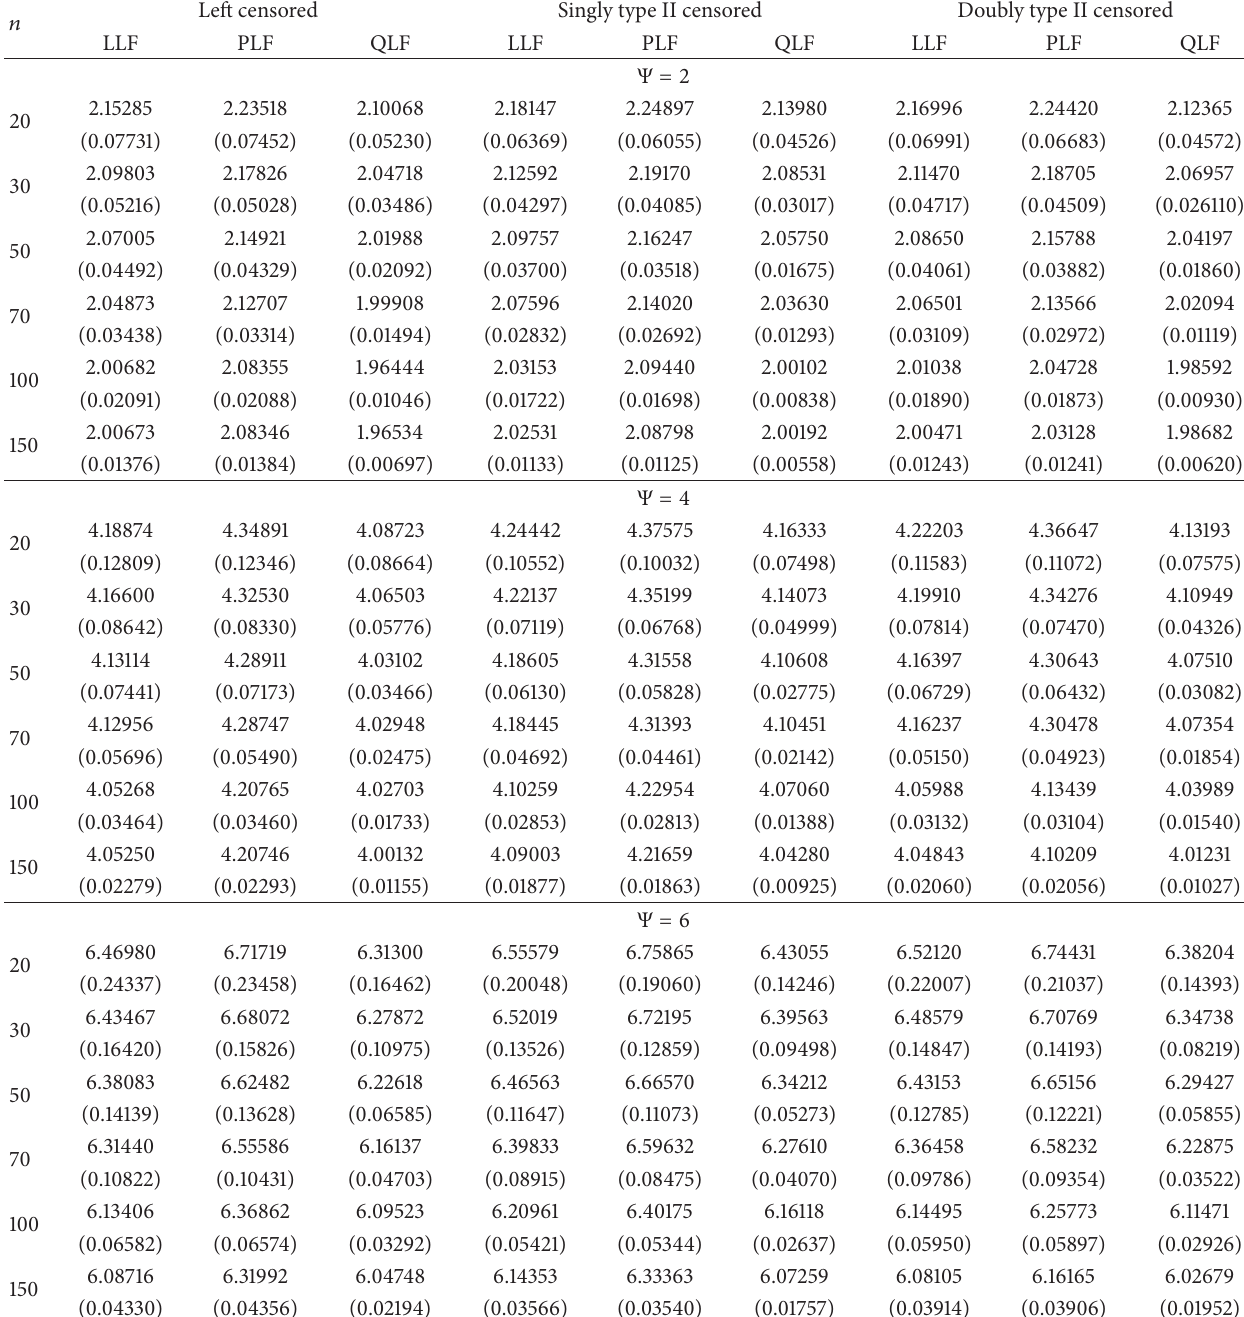
Table 5: Bayes estimators and posterior risks under inverse Levy